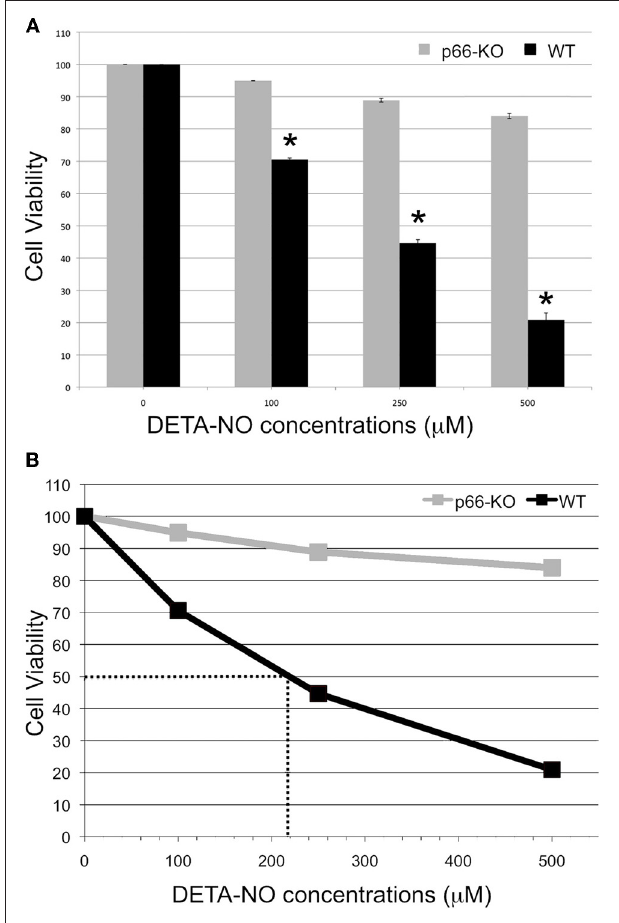
FIGURE 3 | p66-KO neurons are more resistant to DETA-NO treatment compared to WT neurons. Week-old p66-KO and WT hippocampal neurons were treated with various concentrations of DETA-NO (100, 250, and 500 μ M) for 3h. Cell counts were obtained 24h post-treatment using Calcein AM as a viability indicator. (A) Cell viability percentages were significantly greater for the p66-KO neurons compared to the WT neurons for the tested DETA-NO concentrations. ( ∗ = p < 0 . 05). (B) DETA-NO concentration vs. survival percentage curves showed that the EC50 for 50% survival was approximately 220 μ M for WT neurons and beyond experimental treatment concentrations for the p66-KO neurons, demonstrating that p66 elimination is associated with considerably increased resistance to DETA-NO treatment ( n per treatment/genotype = 3 cultures; 4